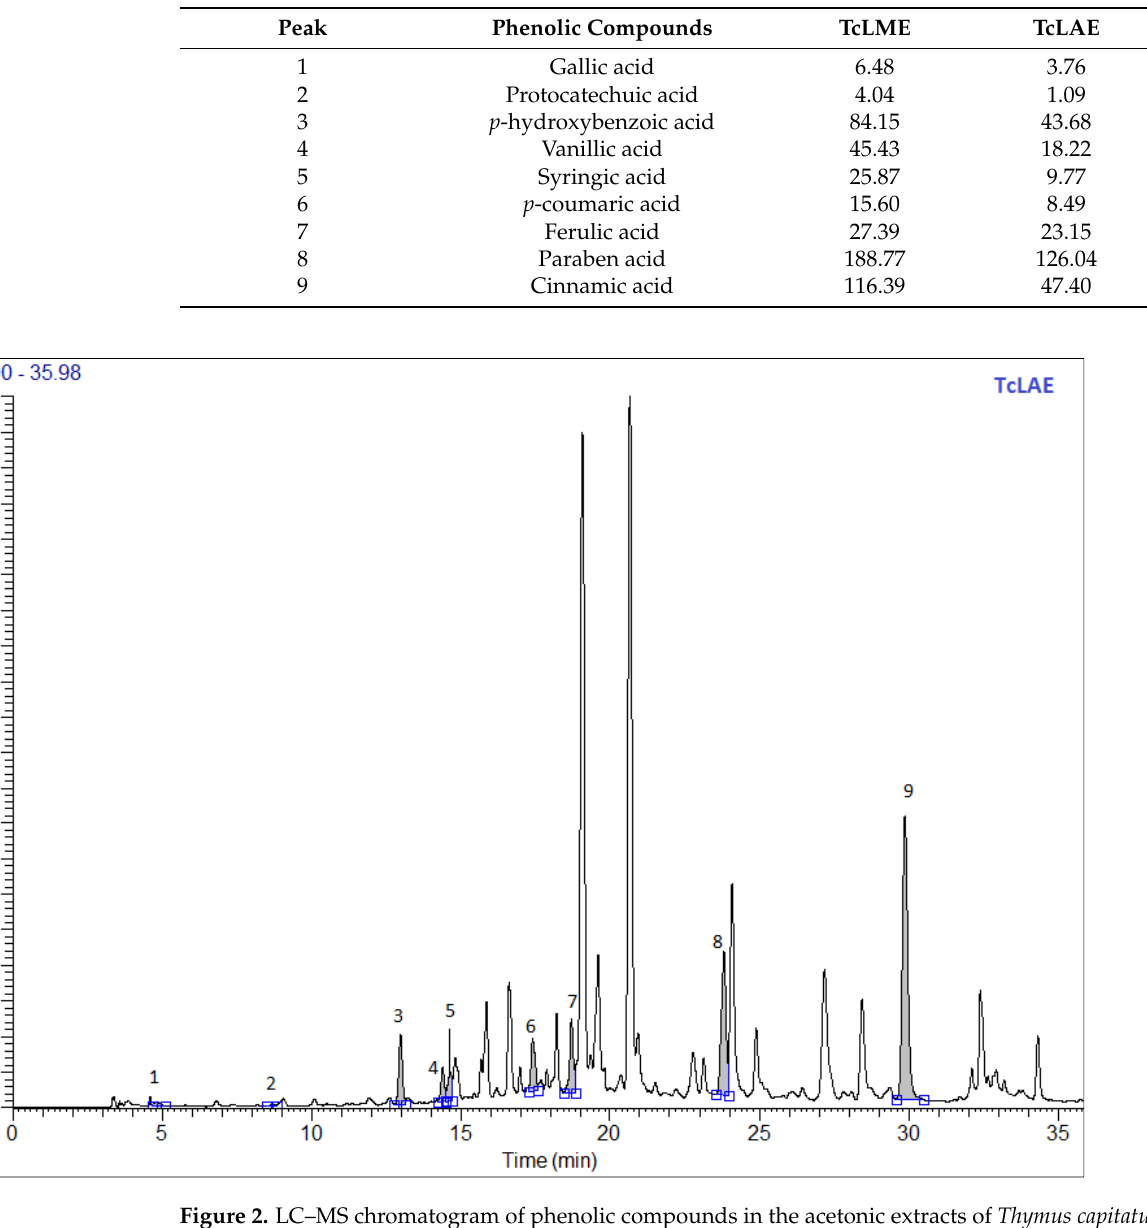
Table 2. Quantification of phenolic compounds in the methanolic (TcLME) and acetonic (TcLAE) extracts of Thymus capitatus leaves ( µ g/g of DE).